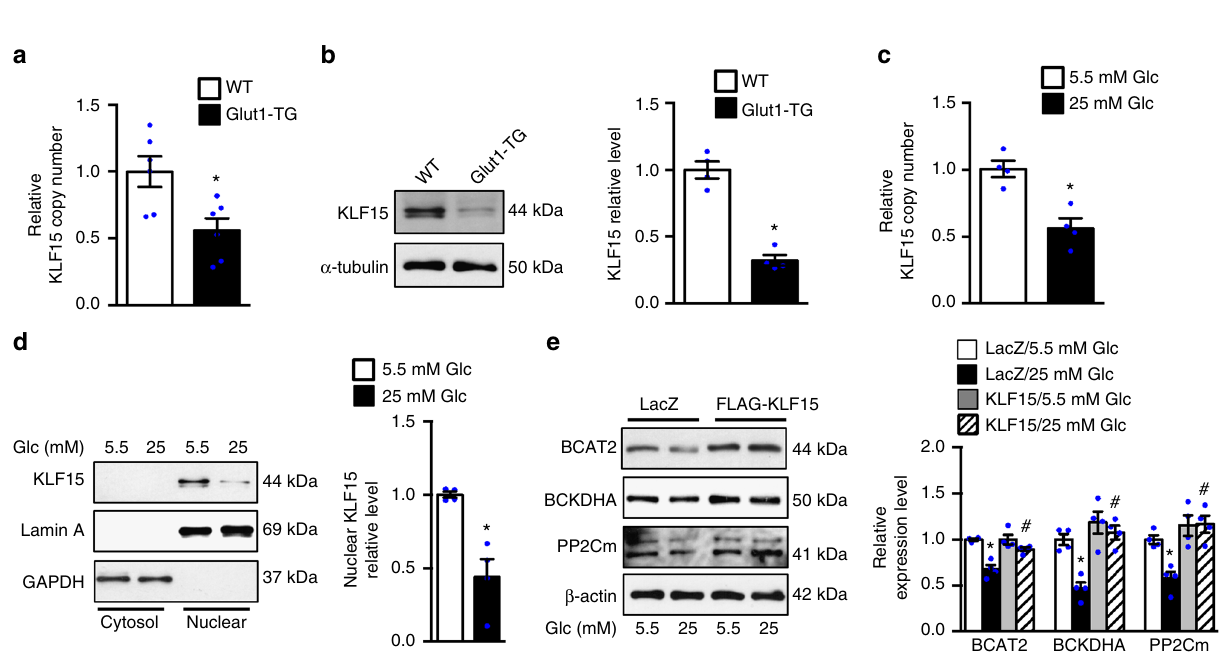
in Fig. 1b are shown in blue. Degradation of Leu, Ile, and Val share the same initial steps catalyzed by Bcat2, Bckdha, Bckdhb, PP2Cm, and Dbt. Leu leucine, Ile isoleucine, Val valine, KIV α -ketoisovalerate, 3-MB-CoA 3-Methylbutanoyl-CoA, 2-MB-CoA 2-Methylbutanoyl-CoA, IB-CoA Isobutyryl-CoA, MC-CoA 2-Methylcrotonyl-CoA, MG-CoA 2-Methylglutaconyl-CoA, MA-CoA 2-Methylbutanoyl-CoA, MM-CoA Methylmalonyl-CoA. d Representative immunoblots of BCAT2, BCKDHA, PP2Cm, and α -tubulin in heart tissue homogenates (left) and statistical analyses of densitomeric measurements of BCAT2, BCKDHA, and PP2Cm (right) are shown (* p < 0.05 vs. WT, n = 4). e NRCMs were incubated with DMEM containing 5.5 mM or 25 mM glucose are shown (* p < 0.05 vs. 5.5 mM Glc, n = 4). Glc glucose. f The relative intensity of indicated BCAAs and their metabolites measured by